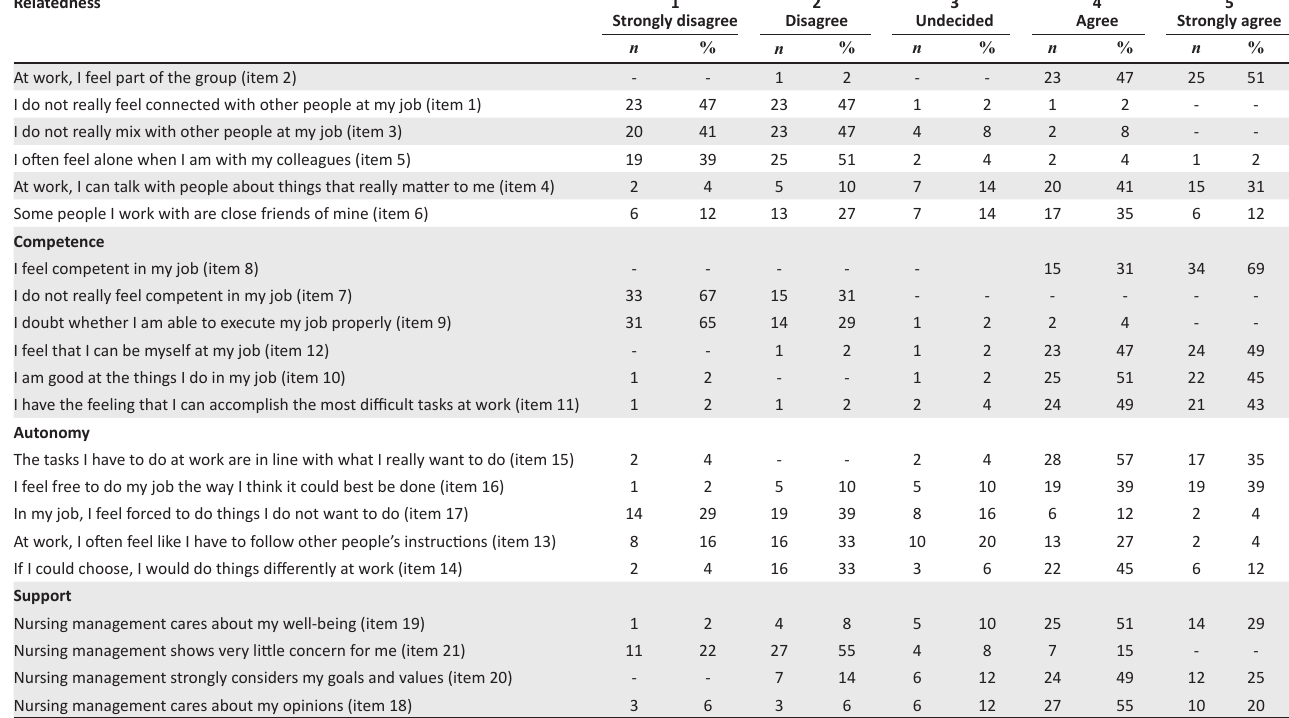
TABLE 3: Descriptive analysis of factors influencing motivation. Relatedness